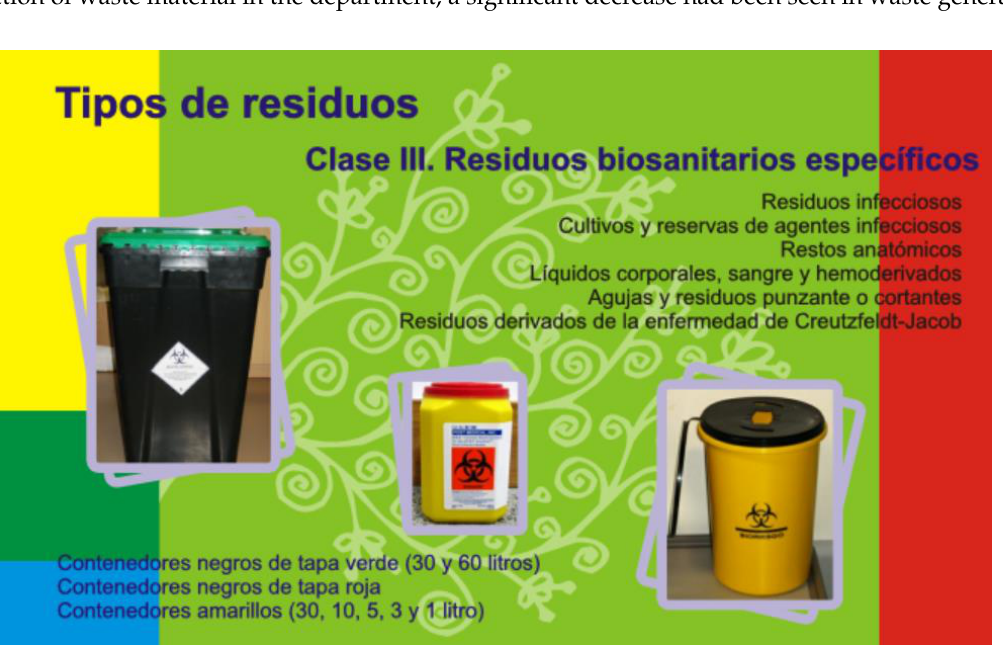
Figure 4. Information on identification of containers and signage.